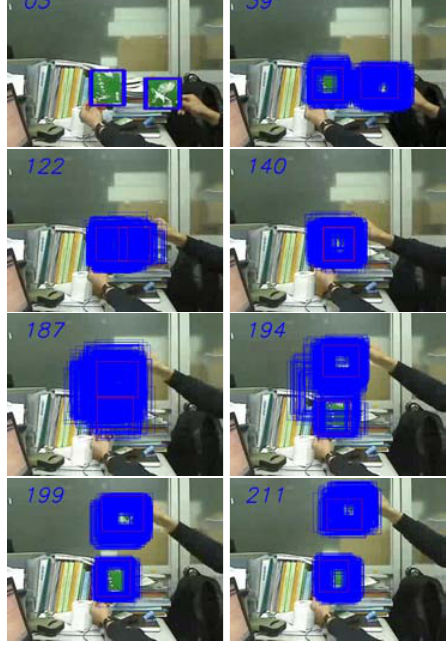
Fig. 5. Two Objects tracking with Occlusion